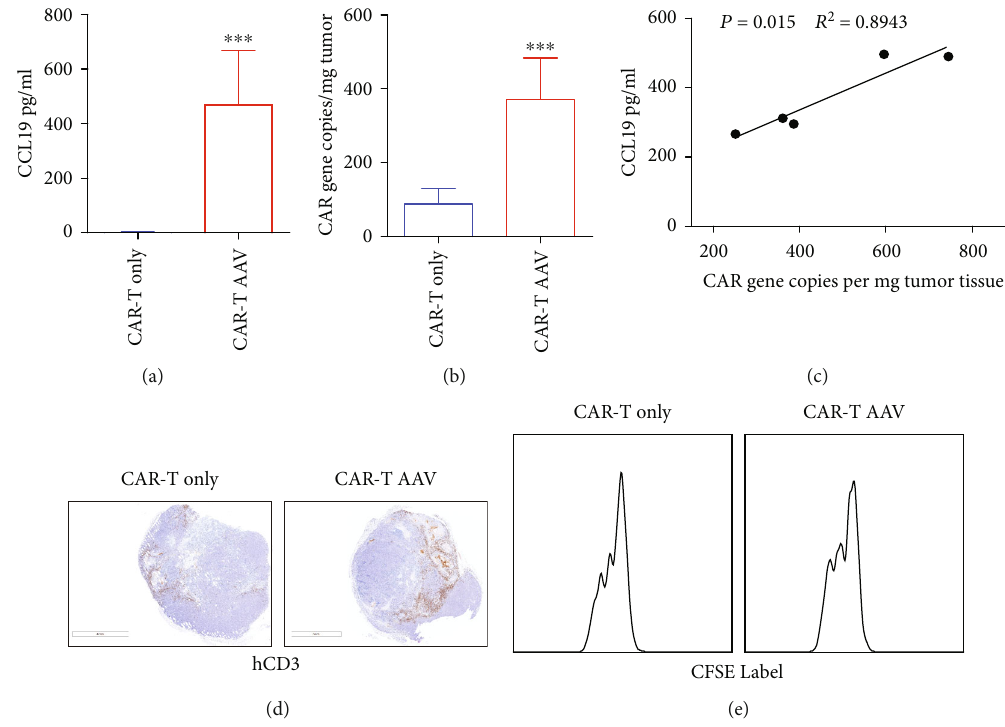
Figure 5: Chemotaxis and in fi ltration of CAR-T cells by intratumoral injection of AAV-CCL19. (a) Analysis of CCL19 levels in peripheral blood; (b) analysis of the CAR gene content in tumor tissues; (c) Correlation analysis between in fi ltrated CAR-T cells and CC19 concentration in peripheral blood; (d) human CD3 T cell data performed by IHC after 7 days CAR-T infusion; (e) analysis of proliferation of in fi ltrated T cell performed by FACS. Error bars represent mean ± SD ( n = 5 ); ns: no signi fi cant di ff erence ∗∗ P < 0 : 01 ; ∗∗∗ P < 0 : 001